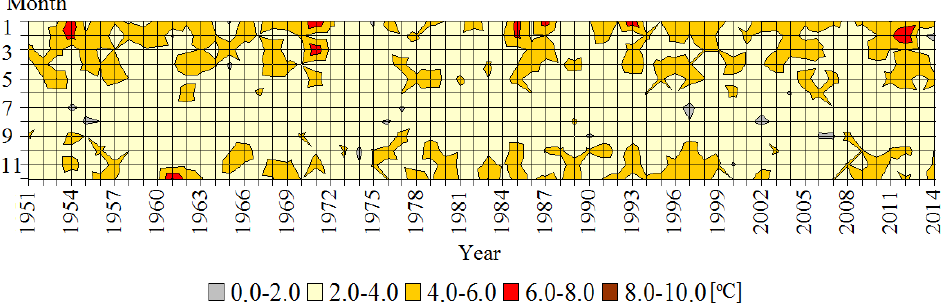
Figure 3. Monthly variation in the standard deviation of daily mean temperature (Ta) in the studied region, 1951–2014.